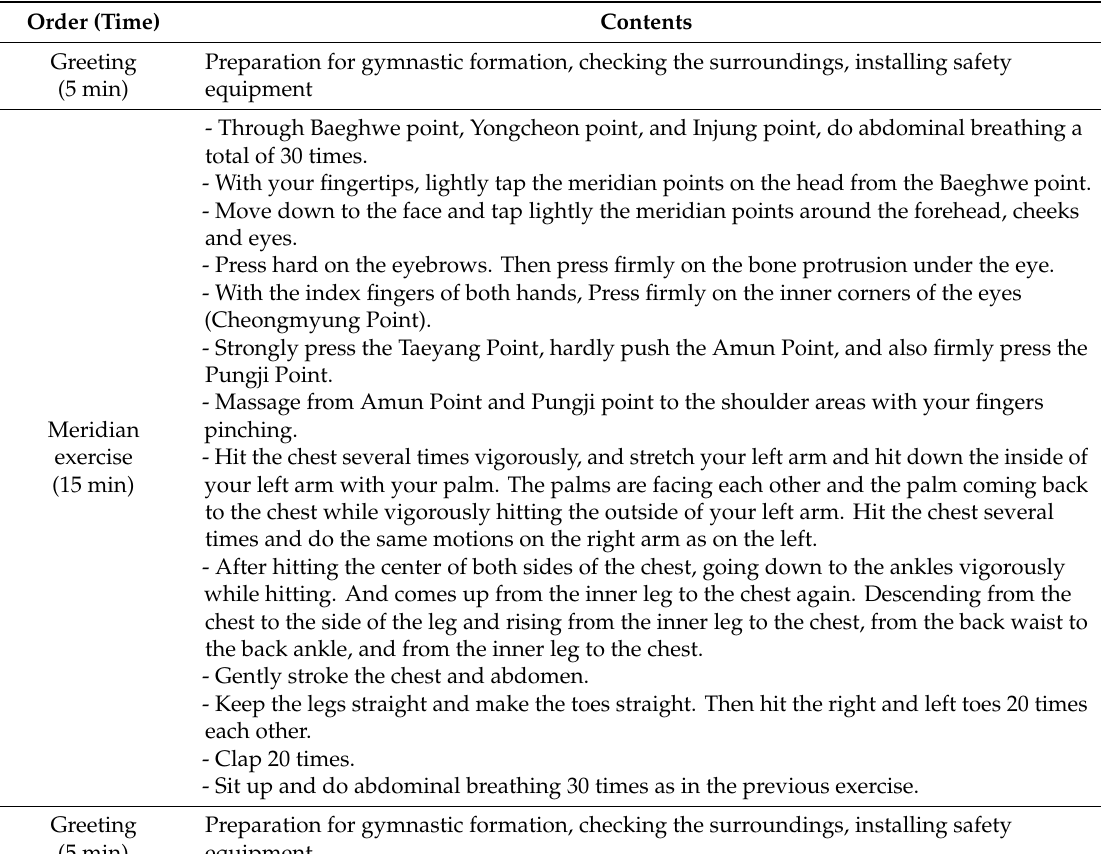
Table 1. Contents of Yangsaeng